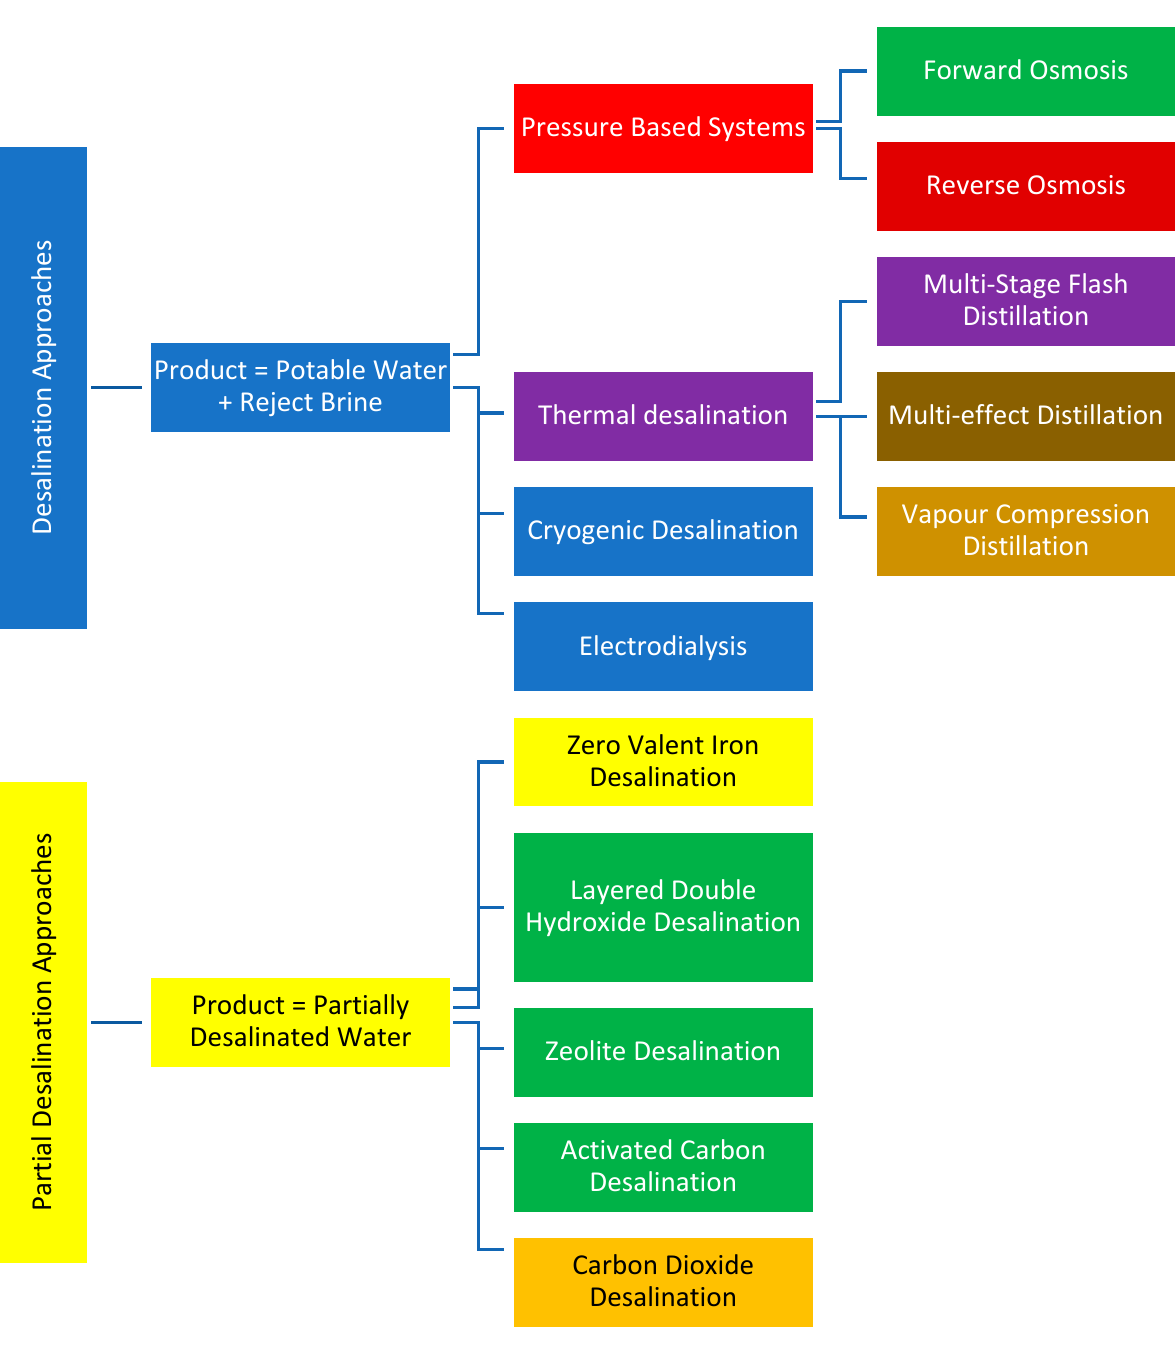
Figure A1. Approaches used to produce desalinated water and partially desalinated water. This study uses zero ‐ valent iron desalination to partially desalinate water.